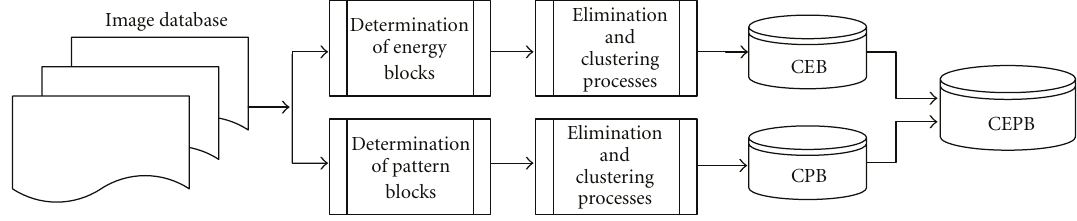
Figure 1: Construction process of the